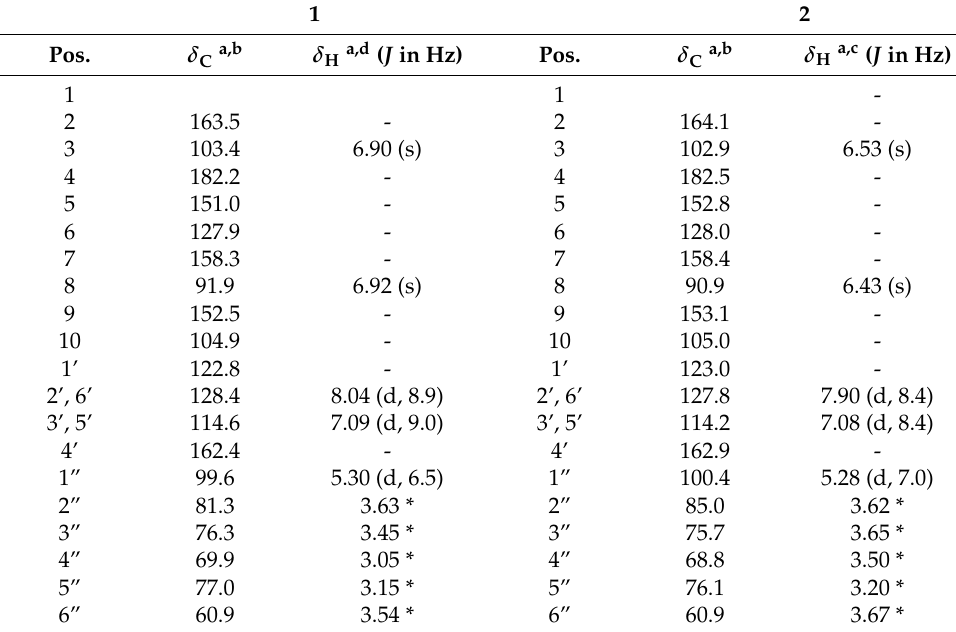
Table 1. NMR spectroscopic data for compounds 1 and 2